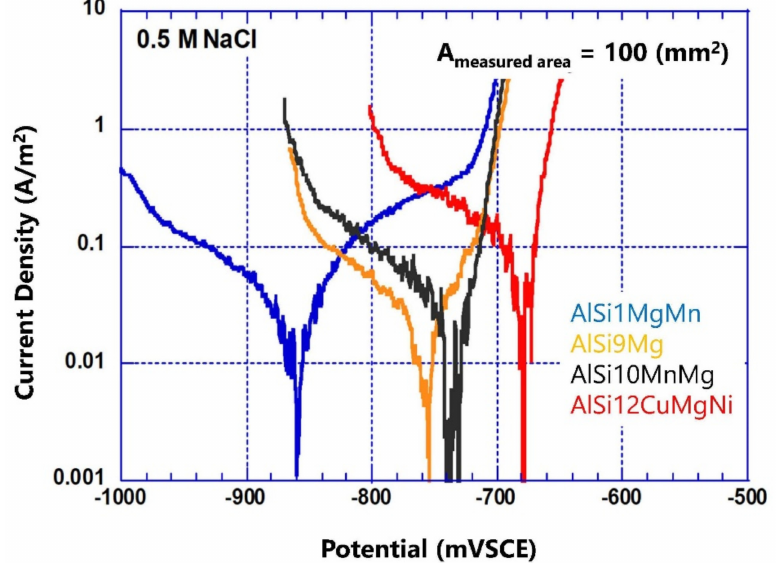
Figure 7. Current density–potential curves of the investigated aluminum alloys. Table 2. Corrosion chemical characterization of the aluminum alloys investigated—typical values of aluminum (99%) included for